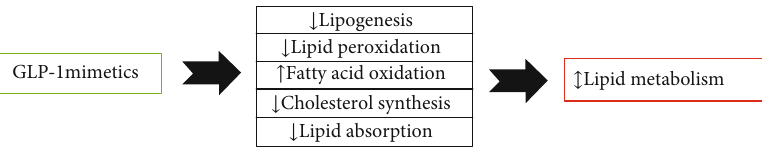
Figure 3: The di ff erent impacts of incretin-based medications on lipid